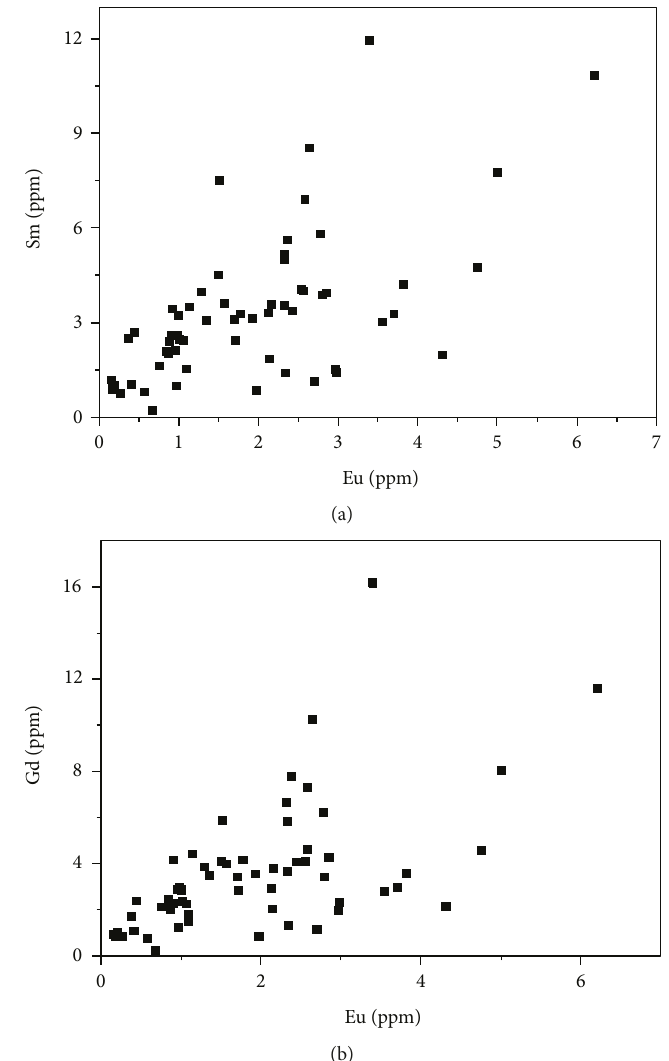
Figure 7: The plots showing the relationship between trace elements in this study. (a) Eu and Sm. (b) Eu and Gd. The Eu-Sm and Eu-Gd correlations can be observed in (a) and (b),